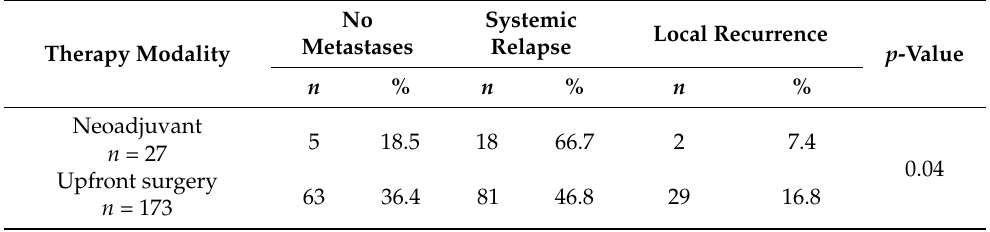
Table 6. Analysis of metachronous disease stratified according to treatment constellation. Rate of systemic relapse was similar between neoadjuvant and upfront surgery-treated patient groups ( p = 0.143; not shown). Local tumor control was significantly improved after neoadjuvant treatment when compared to patients who received upfront surgery ( p = 0.040). Statistical significance was calculated by chi-squared